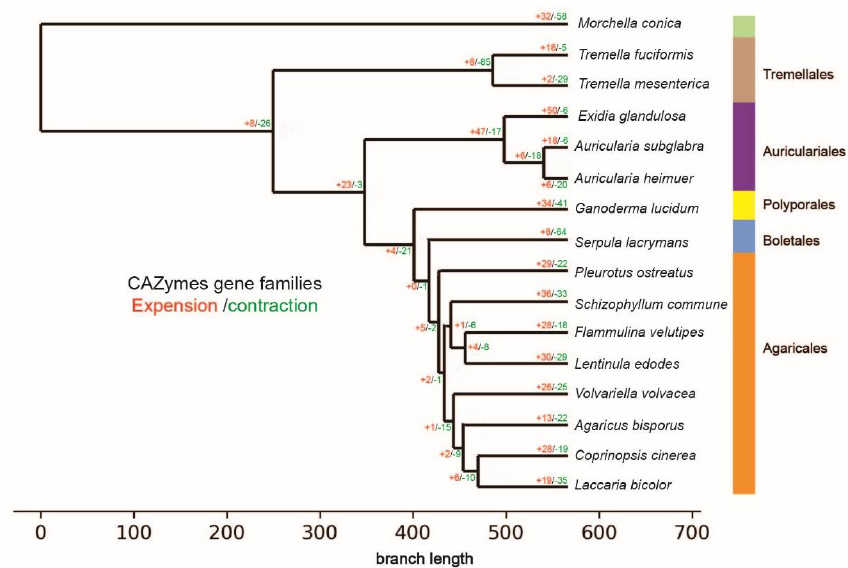
Figure 1. The expansions and contractions of the CAZyme gene families. Numbers associated with each branch designate the numbers of gene families that have expanded (red) or contracted (green) since the split from the common ancestor. The color bars correspond to different orders.